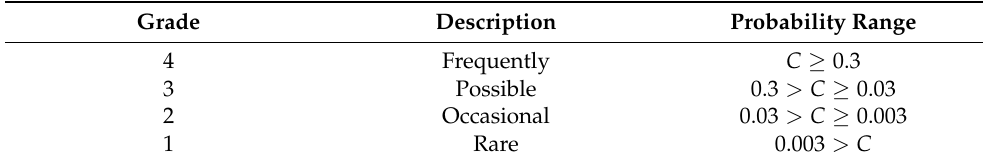
Table 4. The divisions of the safety risk possibilities grades.